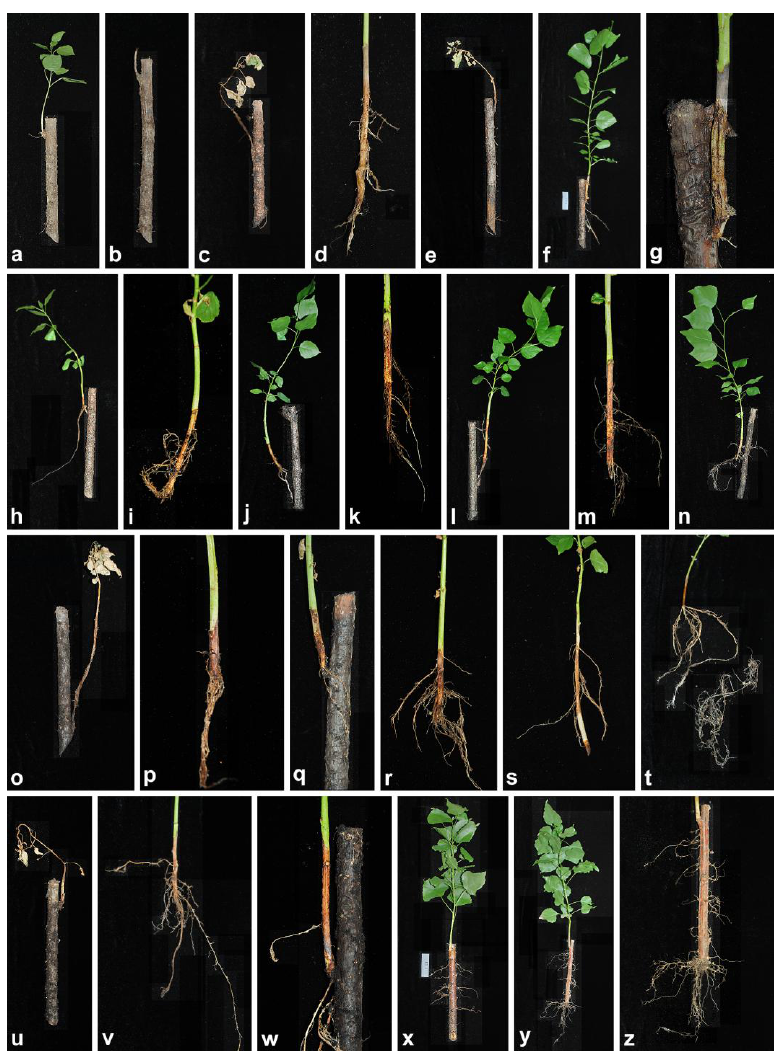
Figure 2. Representative cuttings of poplar clone I-214 after ten weeks in soil infested with nine Phytophthora spp.: ( a , b ) P. cactorum ; ( c , d ) P. cryptogea ; ( e ) P. gonapodyides ; ( f , g ) P. lacustris ; ( h , i ) P. pini KF234655; ( j , k ) P. pini KF234658; ( l , m ) P. plurivora KF234737; ( n , o ) P. plurivora KF234740; ( p , q ) P. polonica JX276065; ( r , s ) P. polonica KF234760; ( t , u ) P. × serendipita ; ( v , w ) P. × cambivora ; ( x , z )